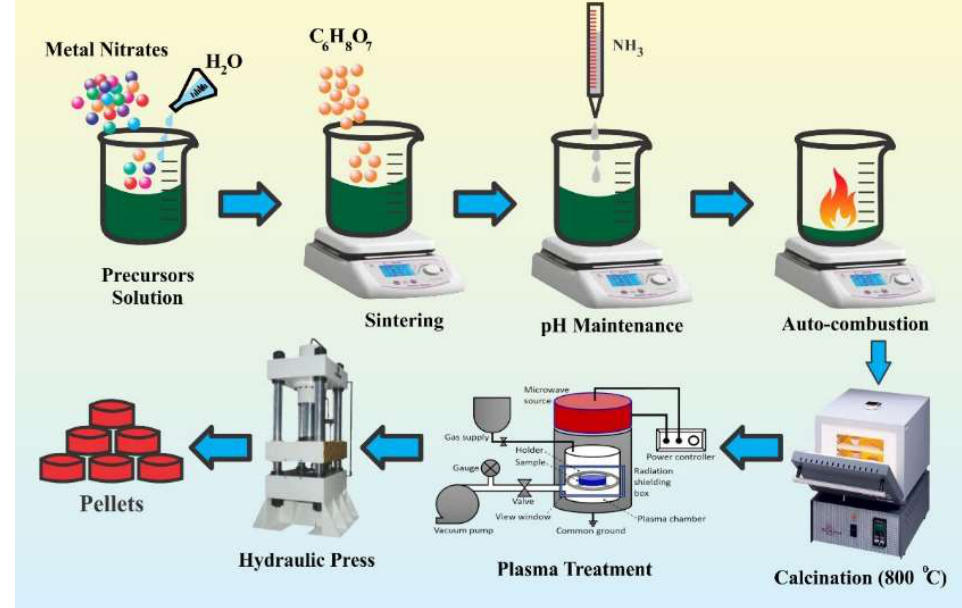
Figure 1. Schematic illustration of synthesis and plasma treatment of ferrites.